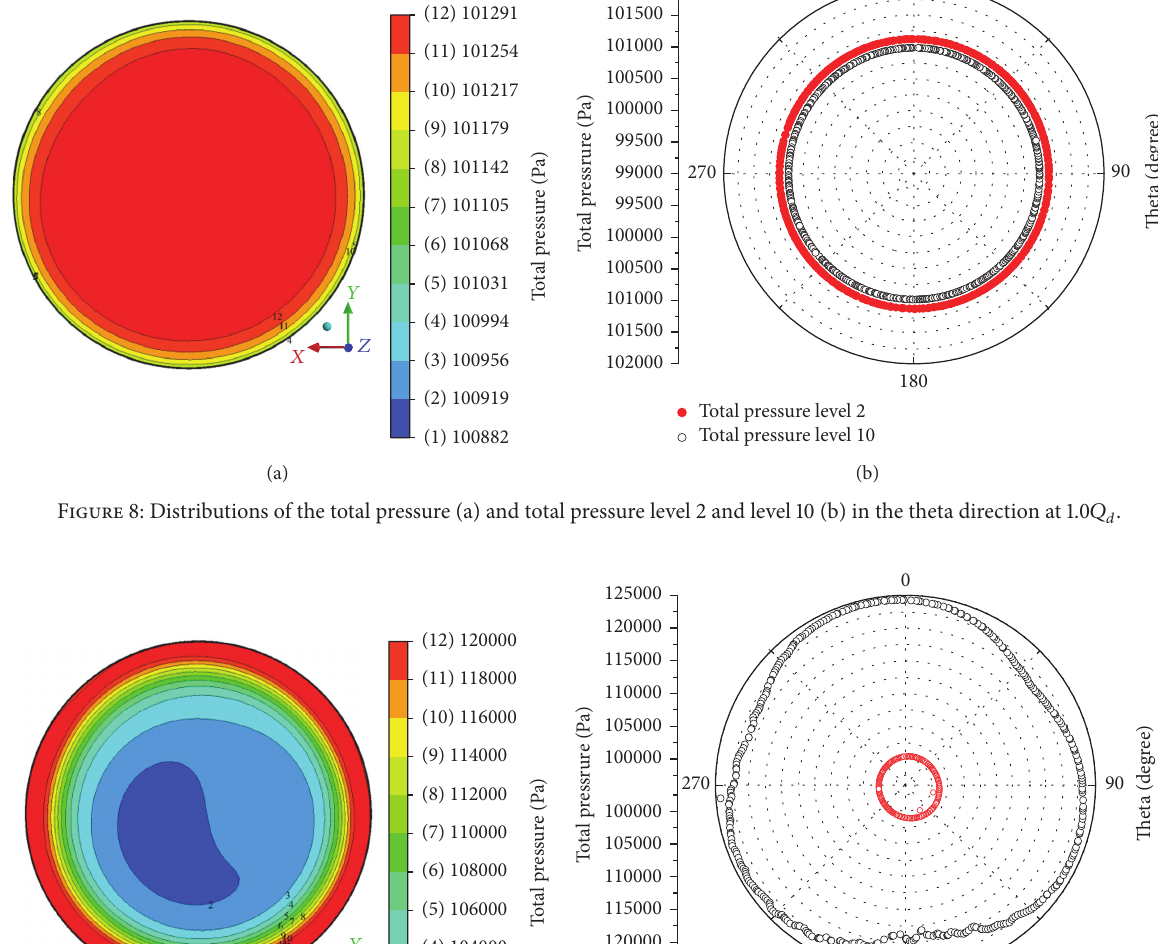
backflow in the inducer inlet at low flow rates becomes stronger and has a negative effect in the main flow in the inlet